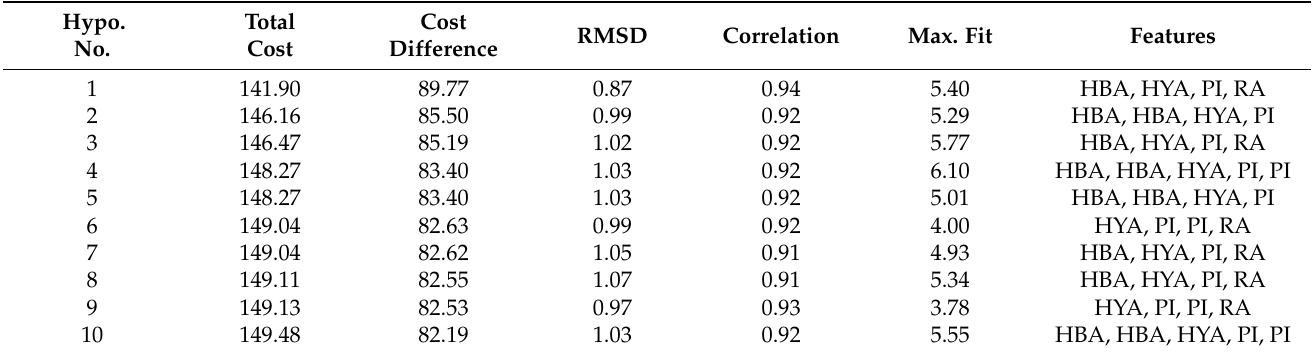
Table 1. Statistical outcomes of the top 10 pharmacophore hypotheses generated by the HypoGen algorithm.